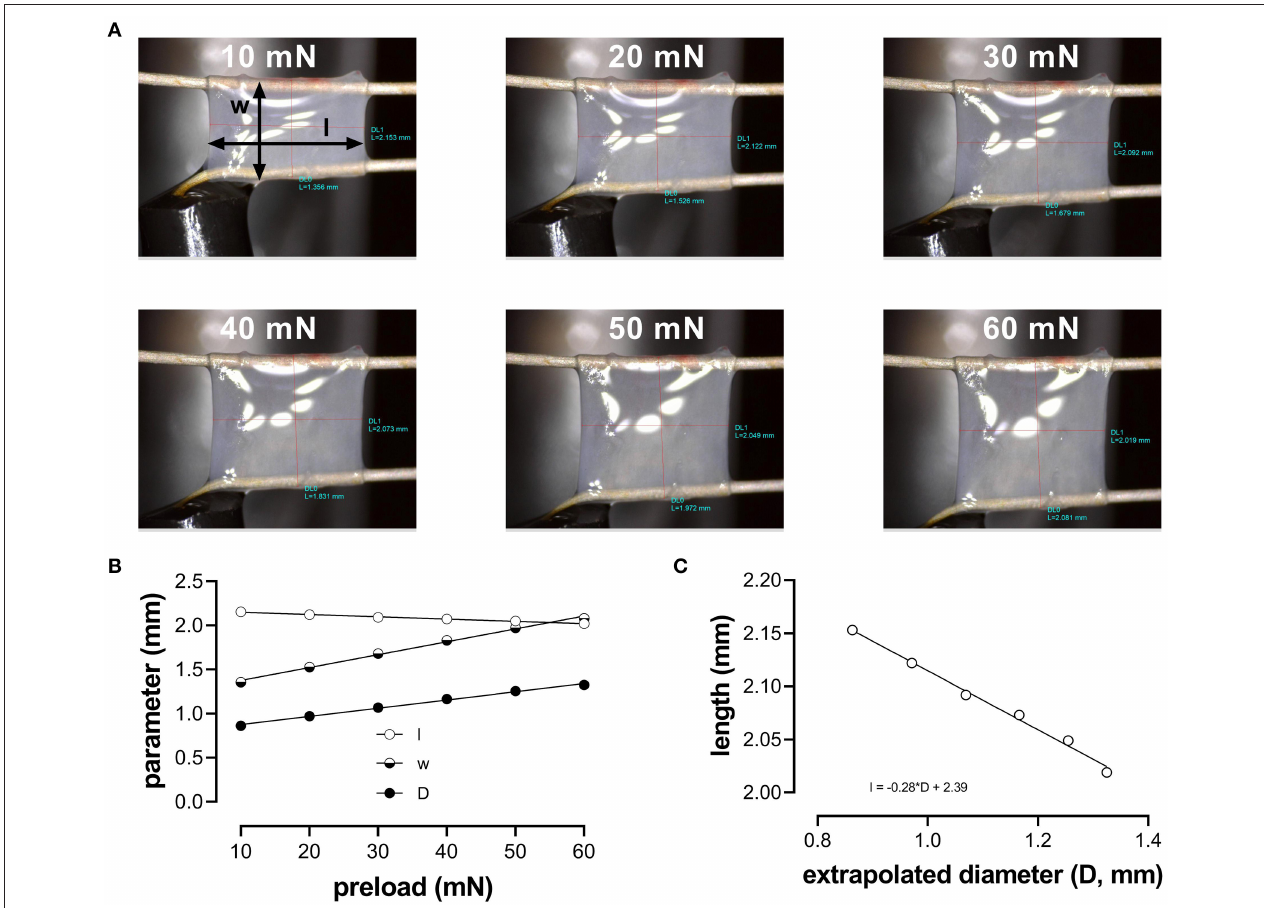
FIGURE 1 | Determination of the aortic segment extrapolated length and diameter. (A) Images of the aortic vessel segment at six different preloads between 10 and 60 mN; (B) length (l), width (w), and extrapolated diameter (D) as a function of preload; (C) relationship between length and extrapolated diameter (to obtain length at each calculated diameter to measure